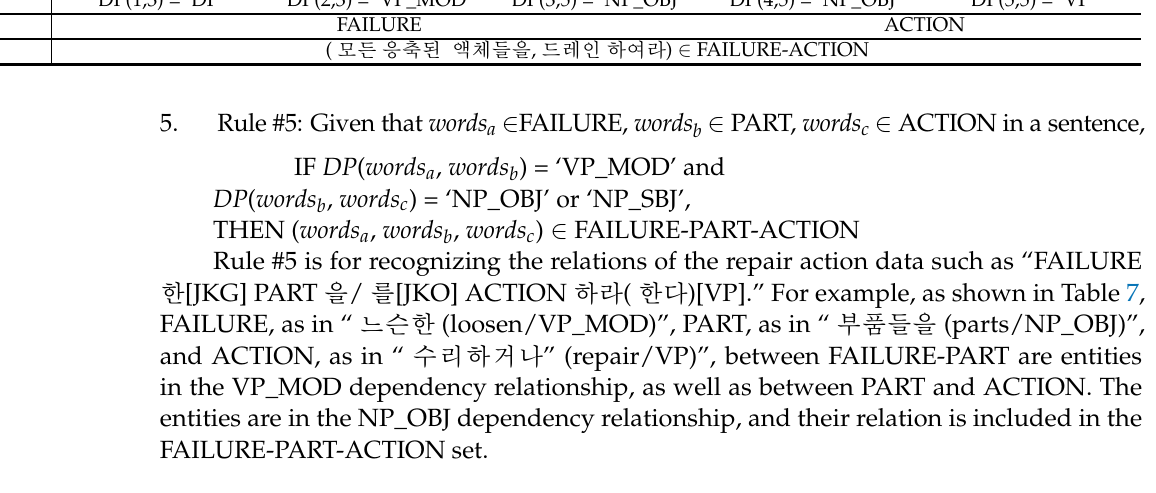
Table 7. An example of the results by applying Rule